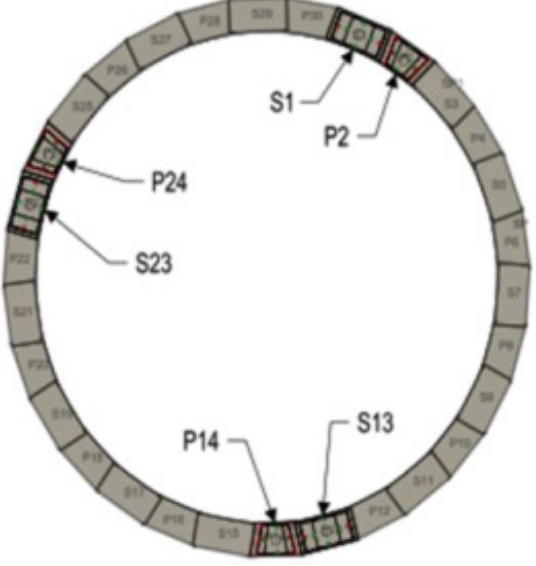
Figure 3: Circular shaft in top view.